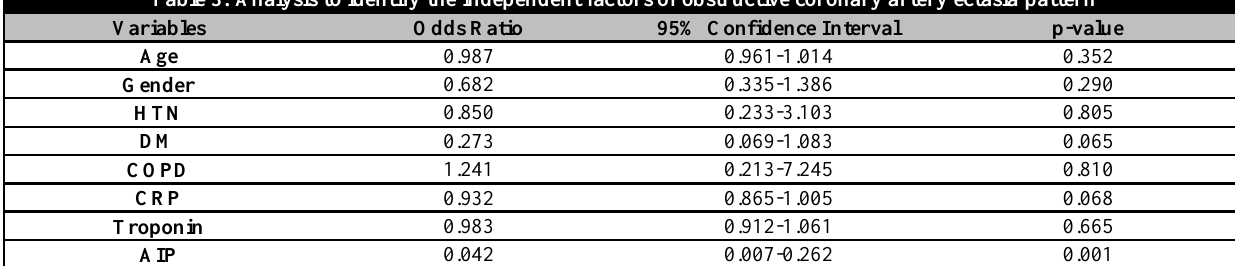
Table 3: Analysis to identify the independent factors of obstructive coronary artery ectasia pattern Variables Odds Ratio 95% Confidence Interval